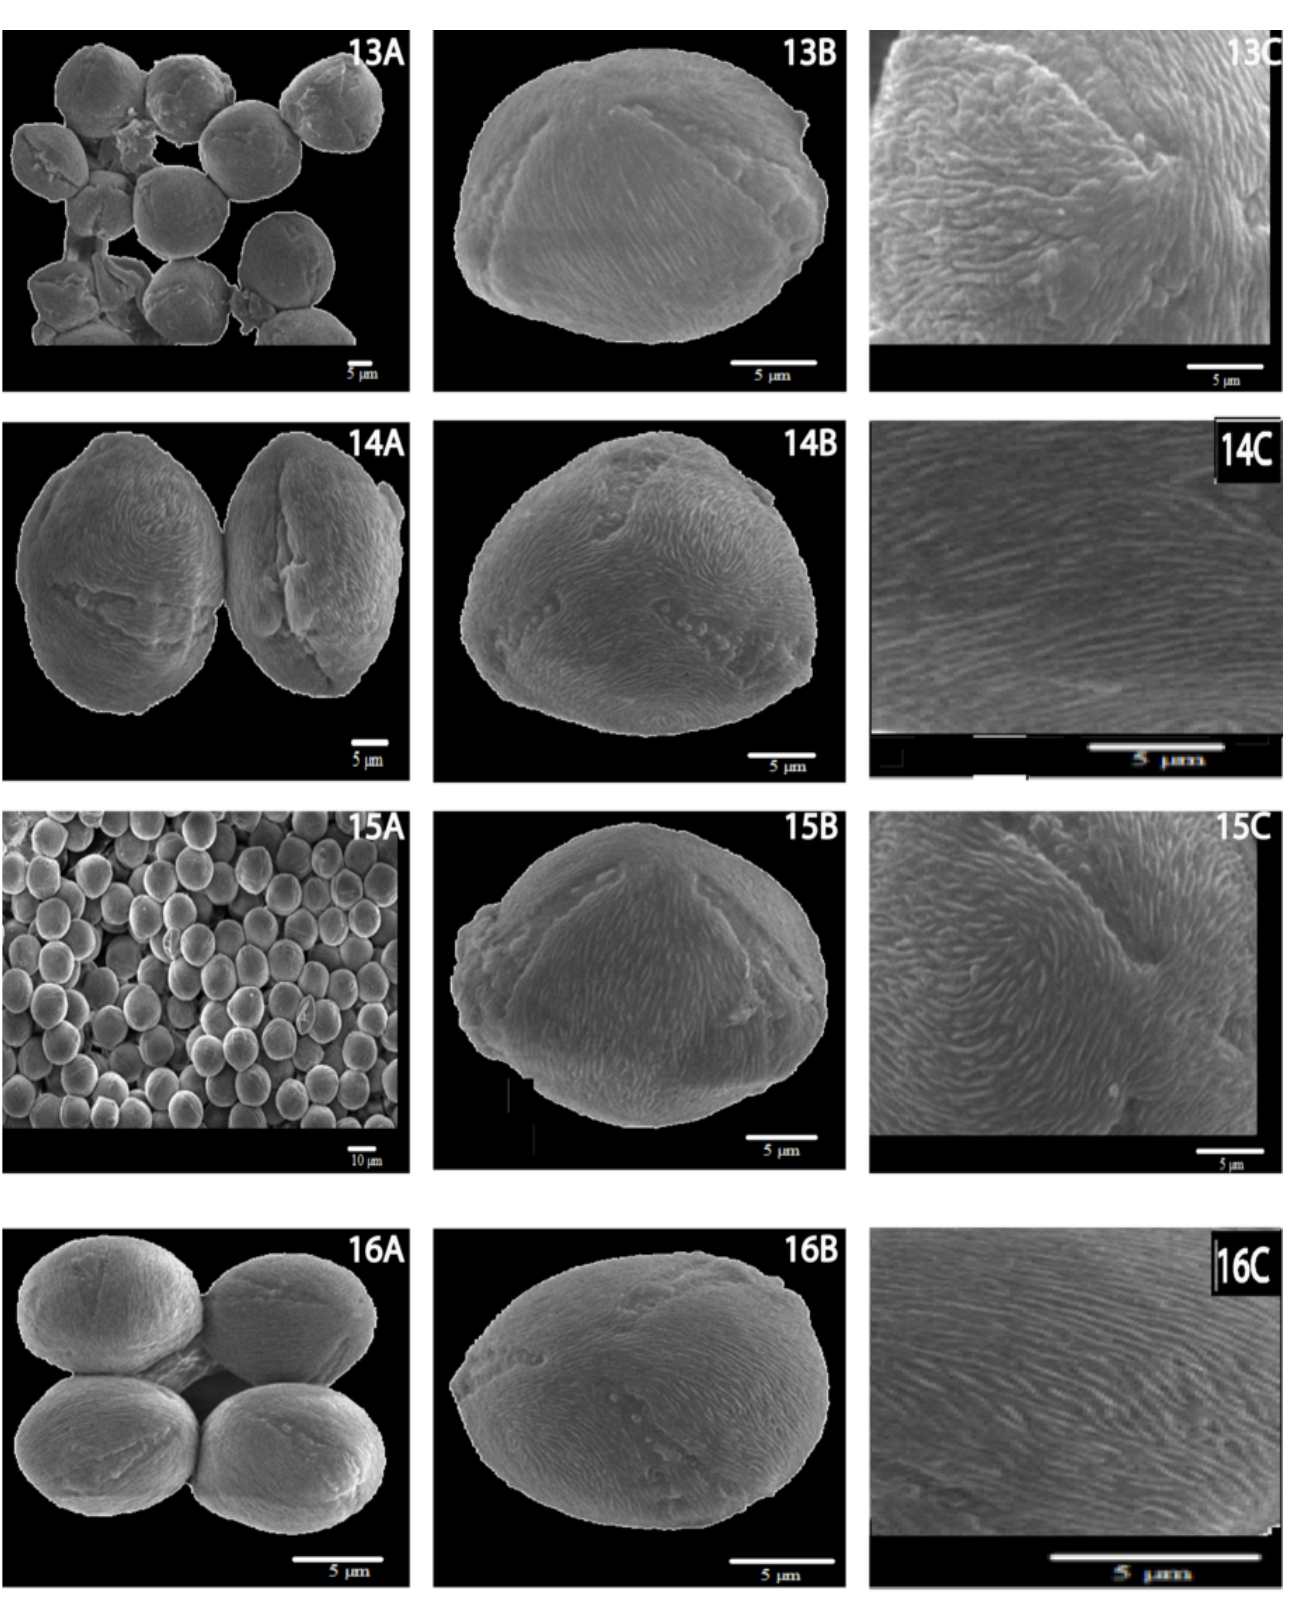
Figure 5. ( A , B ). Different shapes of pollen ( C ). surface 16692-( 13A – 15C ) R. sericea , 17017-( 16A – 16C ) R. sericea .